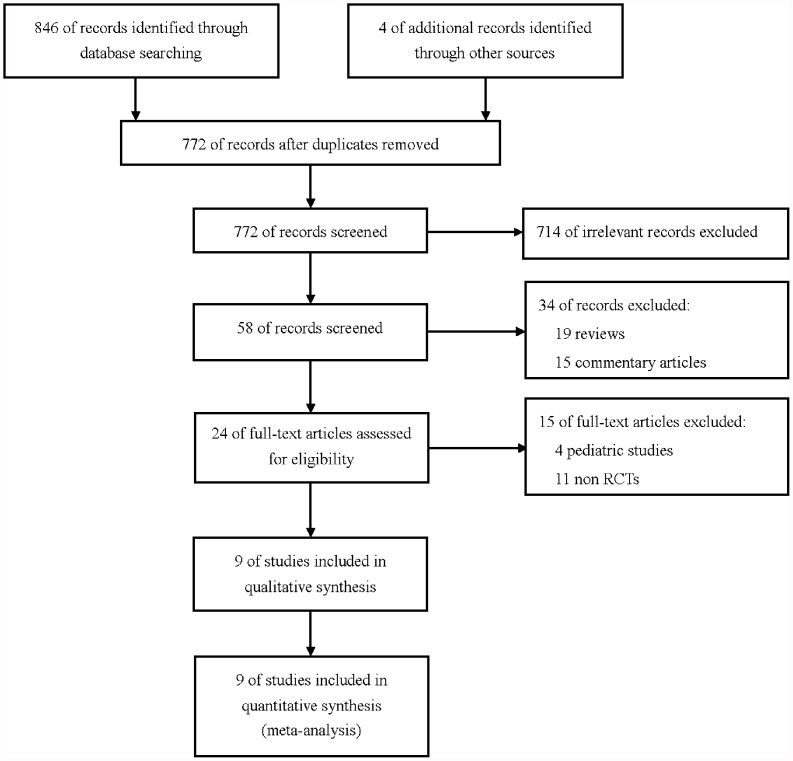
Flow of study identification, inclusion, and exclusion.